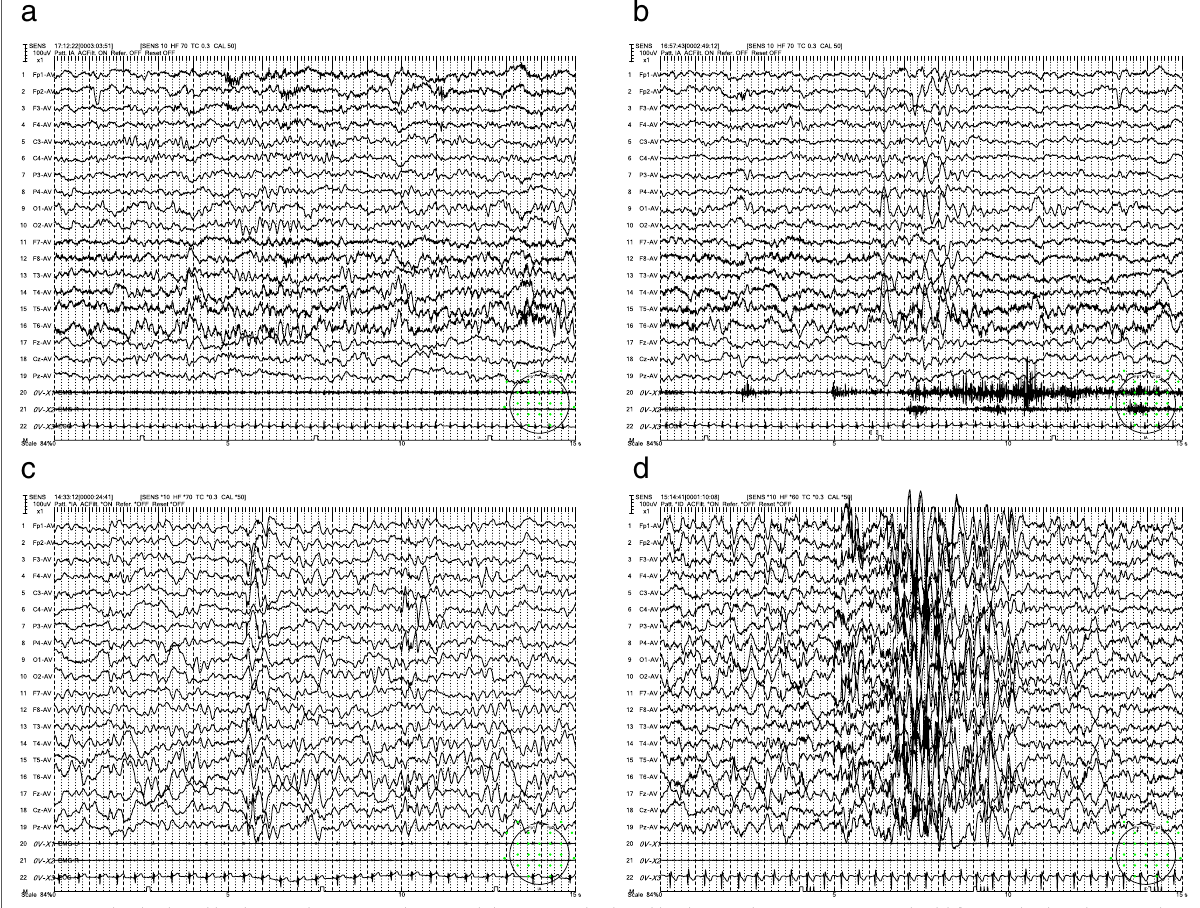
Fig. 1 Results displayed background activity and interictal data. a . EEG displayed background activity at six mouth old. b . EEG displayed interictal data during awake at six mouth old. c . EEG displayed interictal data during asleep at six months old. d . EEG displayed interictal data at 13 months old. Electromyogram: on both deltoid muscles. EEG: